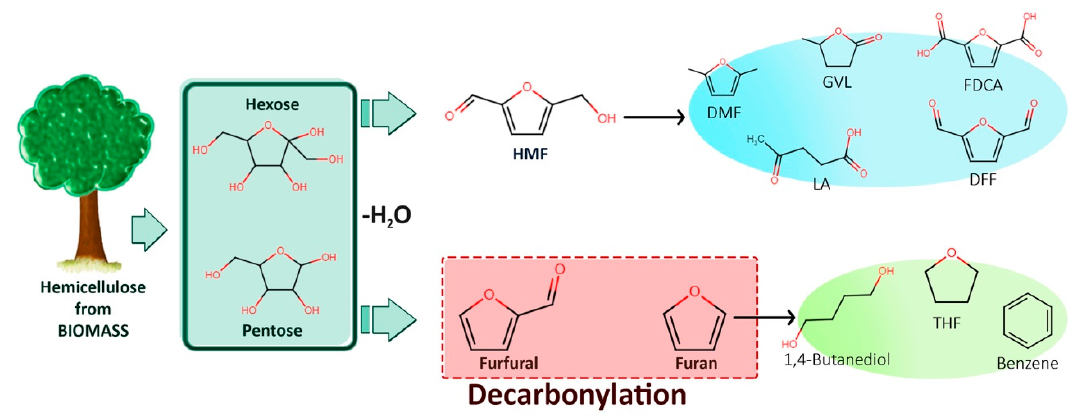
Figure 6. Schematic representation of the main chemical products derived from hemicellulose.